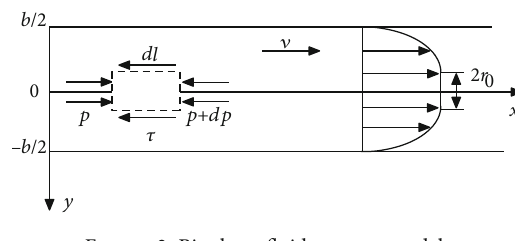
Figure 2: Bingham fl uid seepage